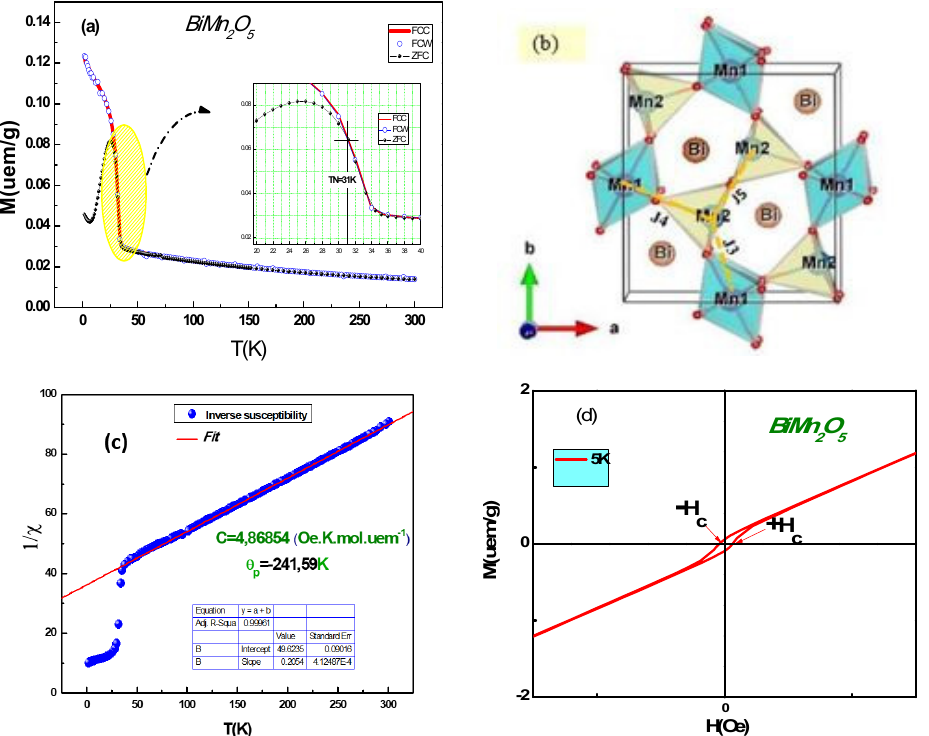
Figure 7. ( a ) Temperature dependence of magnetization for BiMn 2 O 5 in the FC, FCC, and ZFC modes. ( b ) The structure and AFM zigzag spin chains (dashed yellow lines) for BiMn 2 O 5 . ( c ) Temperature-dependent magnetization and inverse susceptibility. The solid line denotes the best fit to the data based on the Curie–Weiss law. ( d ) Field dependence of magnetization at 5K.